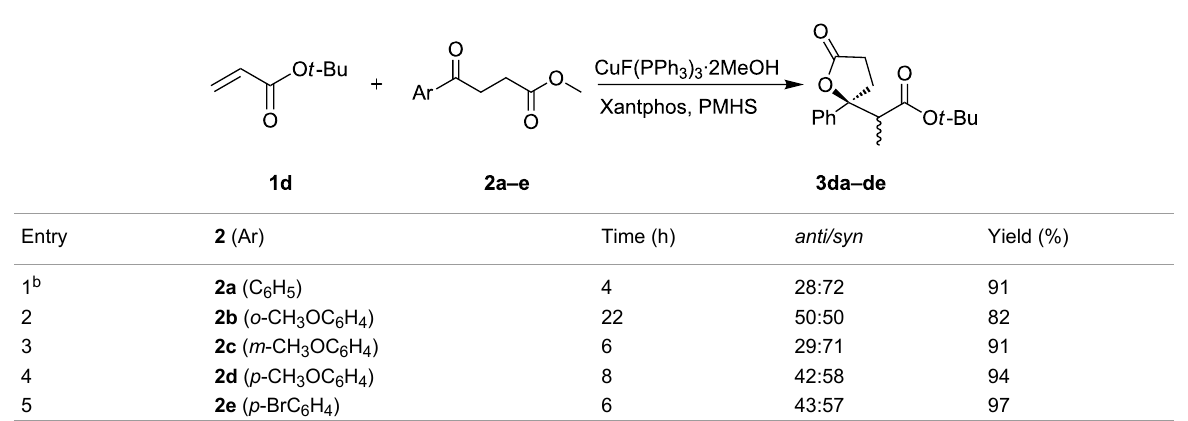
Table 4: Reactions of 4-oxobutanoates with t -butyl acrylate a .